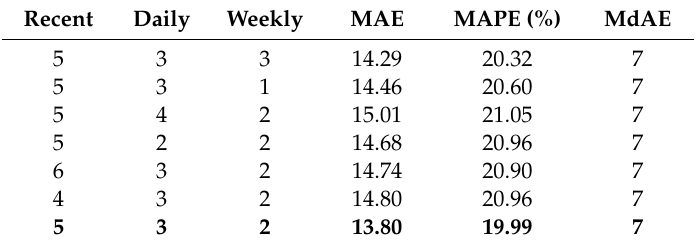
Table 3. Grid search for di ff erent combination of multiple